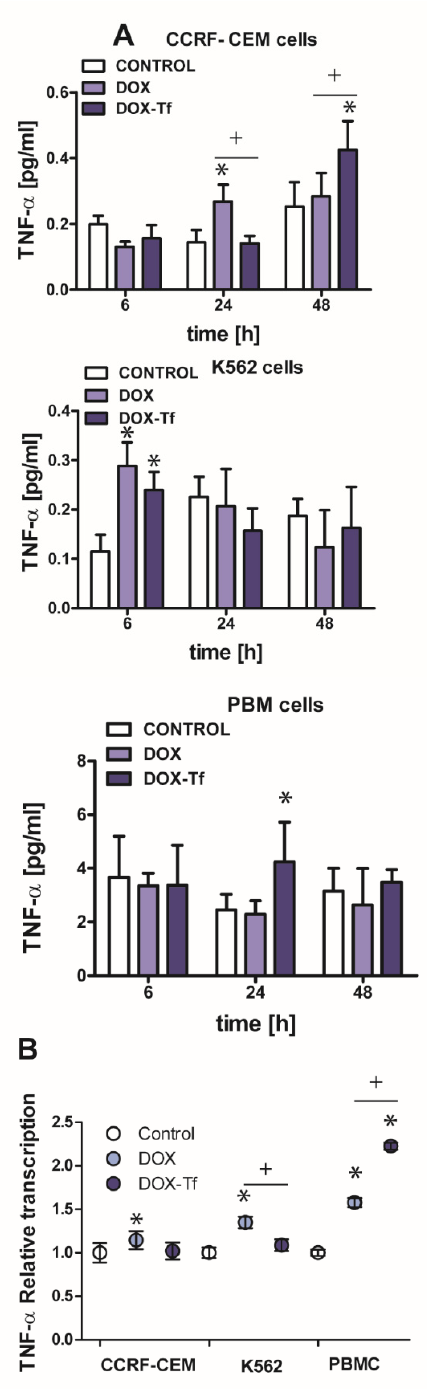
Figure 5. Changes in TNF- α expression in K562 and CCRF-CEM cell lines, and in PBMCs treated with transferrin-bound doxorubicin or free drug ( A ) The e ff ect of IC 50 concentrations of doxorubicin (DOX) and doxorubicin–transferrin (DOX–Tf) conjugate on TNF- α expression. The data represent mean ± SD of three independent experiments. * p < 0.05 in comparison to untreated, control cells, ( + )